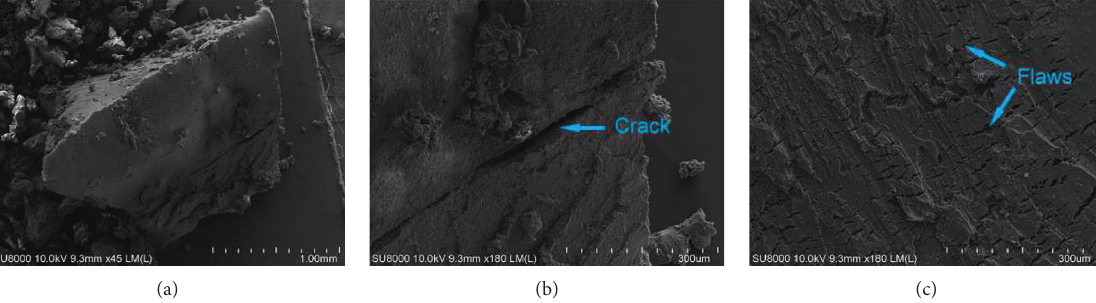
Figure 2: Typical SEM images of the crumb rubber: (a) overview with a 45x magnification; (b) long cracks with a 180x magnification; (c) surface flaws with a 180x